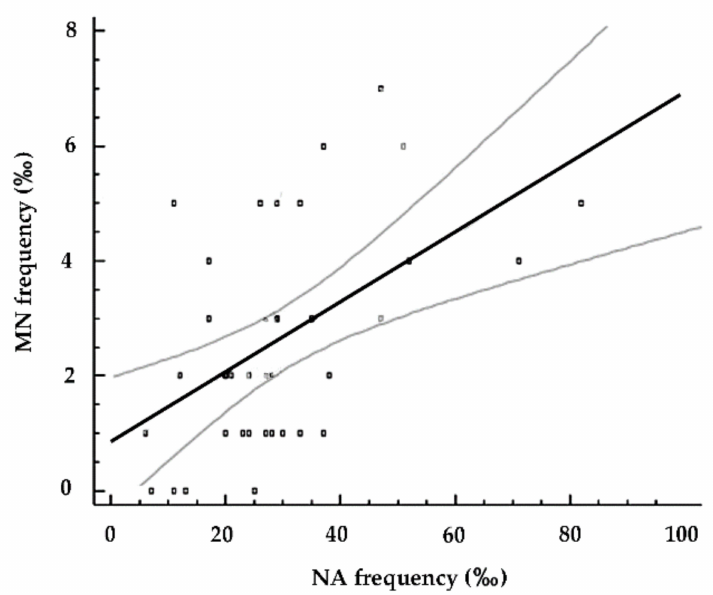
Figure6. RelationshipbetweenMNandNAfrequenciesinzebramusselsfromthedi ff erentexperimental conditions (control, Cd(II), Cd-t CNS, CNS). r = 0.52; R 2 = 27.17; p < 0.001. Black line is the regression line, which represents the regression equation. Gray lines represent 95% of the confidence